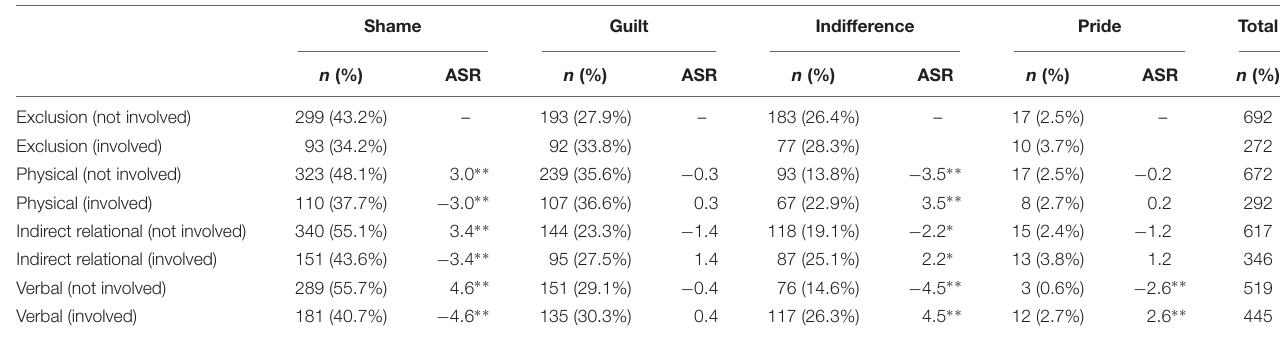
TABLE 2 | Percentages of moral hetero-attribution and forms of bullying of aggressors. Shame